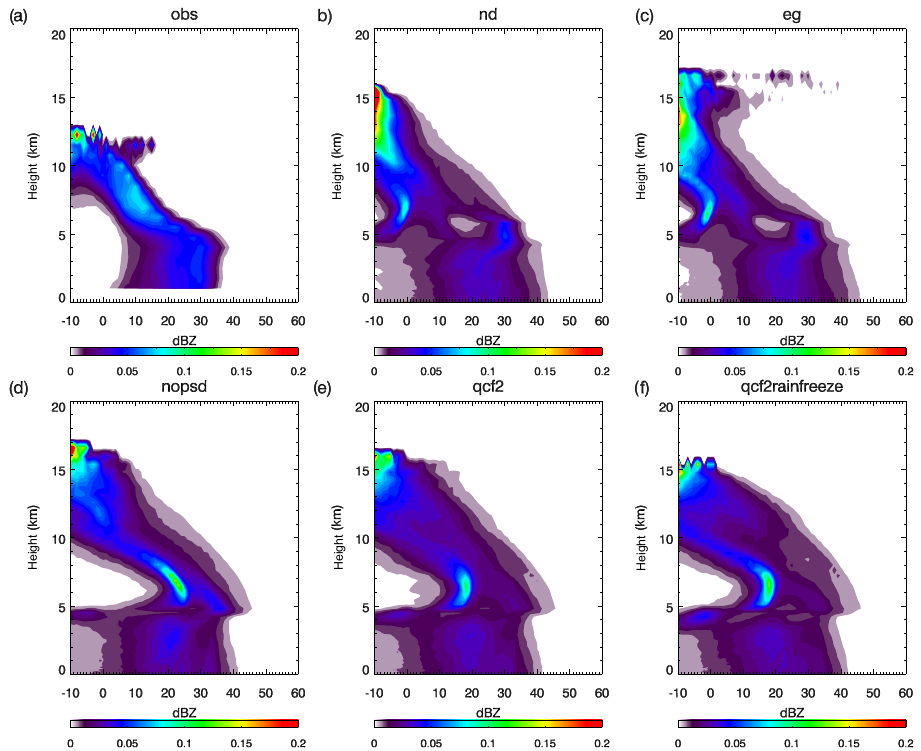
Figure 7. Contoured frequency with altitude diagrams of radar reflectivity for the region within 150km of the radar for the times 23:00– 24:00UTC. (a) Observations, (b) control simulation, (c) ENDGame dynamical core simulation, (d) no use of the generic ice PSD param- eterisation, (e) additional ice prognostic and (f) inclusion of heterogeneous rain-freezing parameterisation. See text for details on different